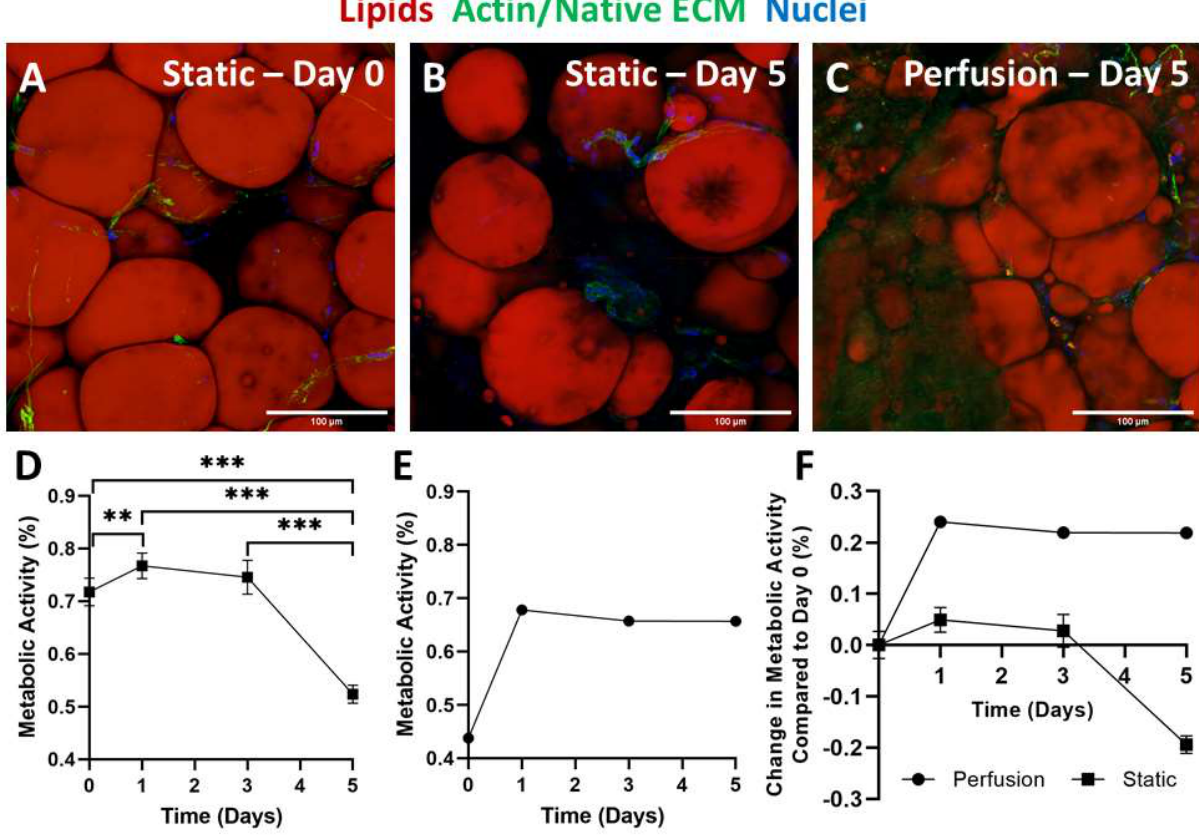
Figure 5. Adipose tissue-filled DLMs cultured in perfusion conditions had a more stable metabolic activity compared to static cultures. ( A , B ) Static samples were imaged on day 0 and day 5 (red—adipocytes, green—actin/native ECM, blue—nuclei). Scale bars = 100 µ m. ( C ) Perfused lobes were imaged at day 5 (red—adipocytes, green—actin/native ECM, blue—nuclei). Scale bars = 100 µ m. ( D ) Resazurin was used to monitor the metabolic activity in static culture conditions, where static culture resulted in a decrease from day 3 to day 5. n = 16 on day 0 and n = 8 on days 1, 3, and 5. ( E ) Resazurin was used to monitor the metabolic activity in perfusion culture. Perfusion culture resulted in a stable metabolic activity over 5 days. n = 1. ( F ) The metabolic activity was measured in both culture conditions and is represented as the change in metab- olism compared to day 0. Perfusion culture resulted in a more stable metabolic activity over 5 days that did not drop as the static culture did. Statistical significance for metabolic activity data was determined using a one-way ANOVA test followed by Tukey’s post hoc test. Asterisks indicate significant (** p < 0.01, *** p < 0.001).